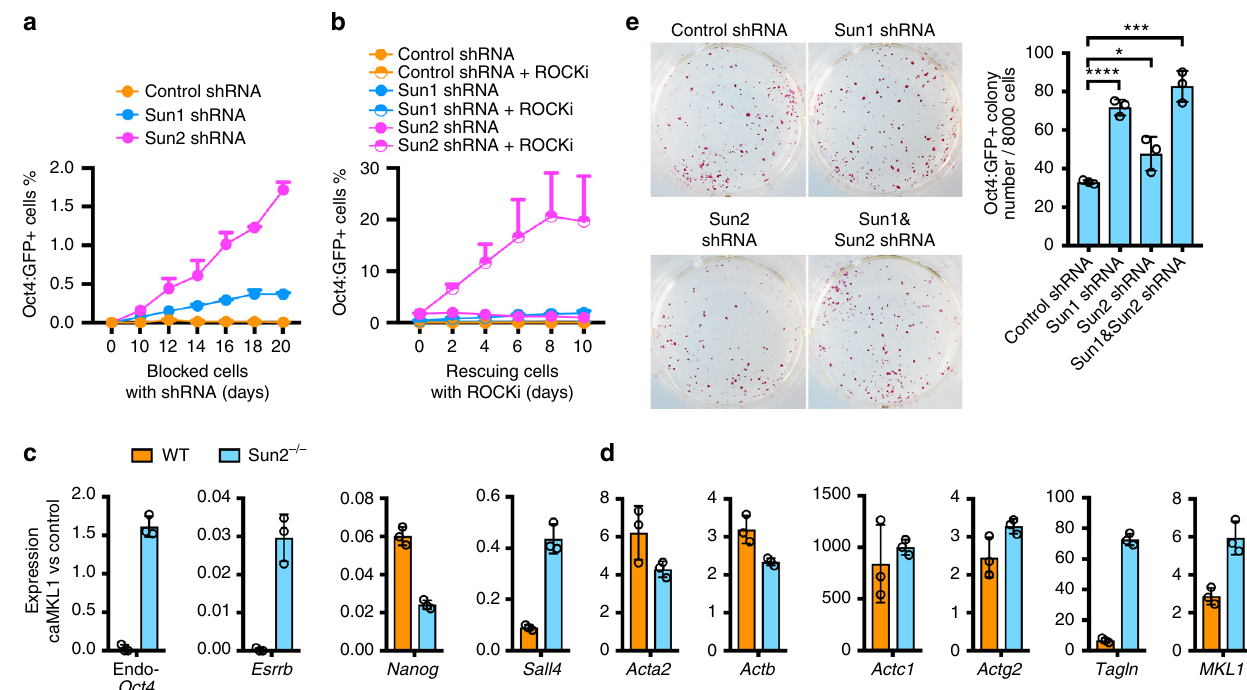
Fig. 4 LINC complex contributes to the block of mature pluripotency activation. a Percentage of Oct4:GFP + cells emerging from blocked cells following treatment of control, Sun1- or Sun2-targeting shRNAs. b The same experiments as in a were performed with or without ROCKi, which was added on day 20 of shRNA treatment. GFP + percentages were determined by FACS at indicated time (days). c , d Realtime QPCR analyses of selected genes in control- or caMKL1-expressing cells, derived from reprogramming WT or Sun2 − / − cells on day 40. Each bar represents the ratio of the indicated gene expression levels in caMKL1- vs control-expressing cells. Endogenous pluripotency genes are shown in c ; MKL1 and its target genes are shown in d . Data are representative of three independent experiments. e AP stained cultures derived from reprogramming MEFs, while treated with control shRNA, Sun1- or Sun2-targeting shRNA, or both (left). The number of Oct4:GFP + colonies were quanti fi ed on the right. * P < 0.05; *** P < 0.001; **** P < 0.0001. All data are representative of three independent experiments. Error bars denote standard deviation of triplicated samples ( n = 3) in each experiment. Statistics